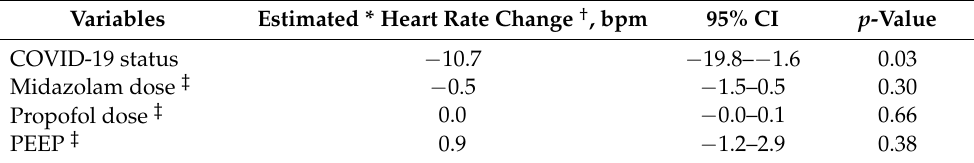
Table 2. Linear regression with parsimonious strategy assessing the influence of the COVID-19 status and covariates on the change in the heart rate during CVVHDF-induced hypotension in critically ill patients.